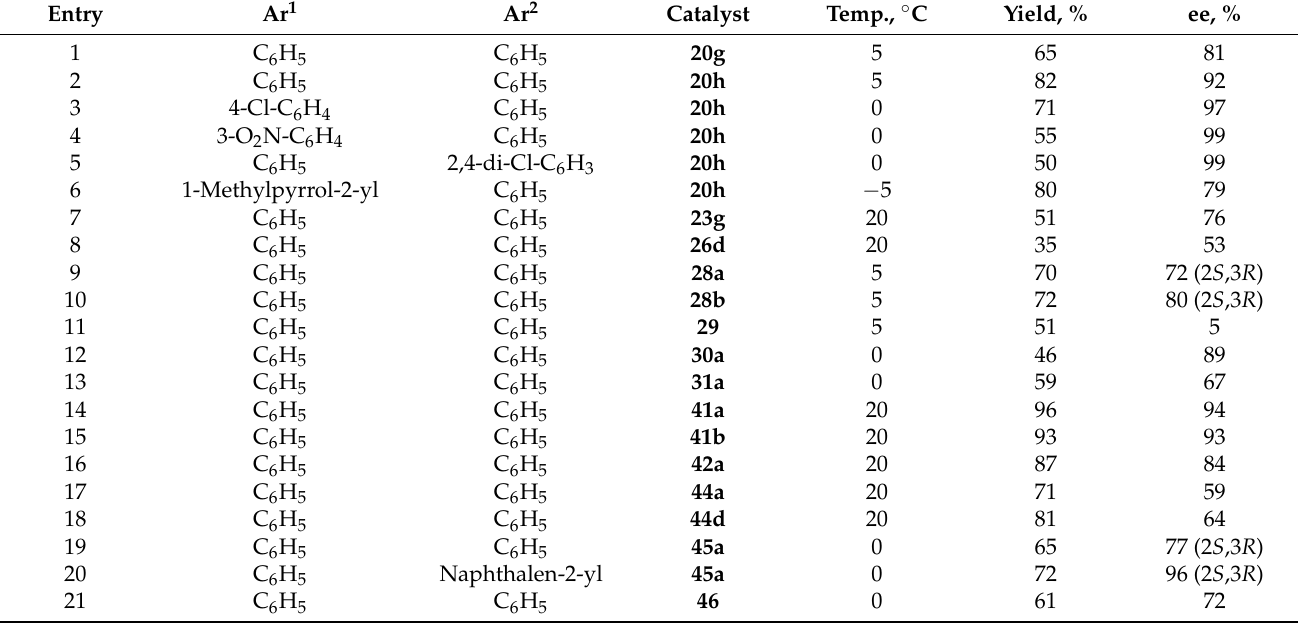
Table 13. Effect of crown ethers in the epoxidation of chalcones ( 49 ).